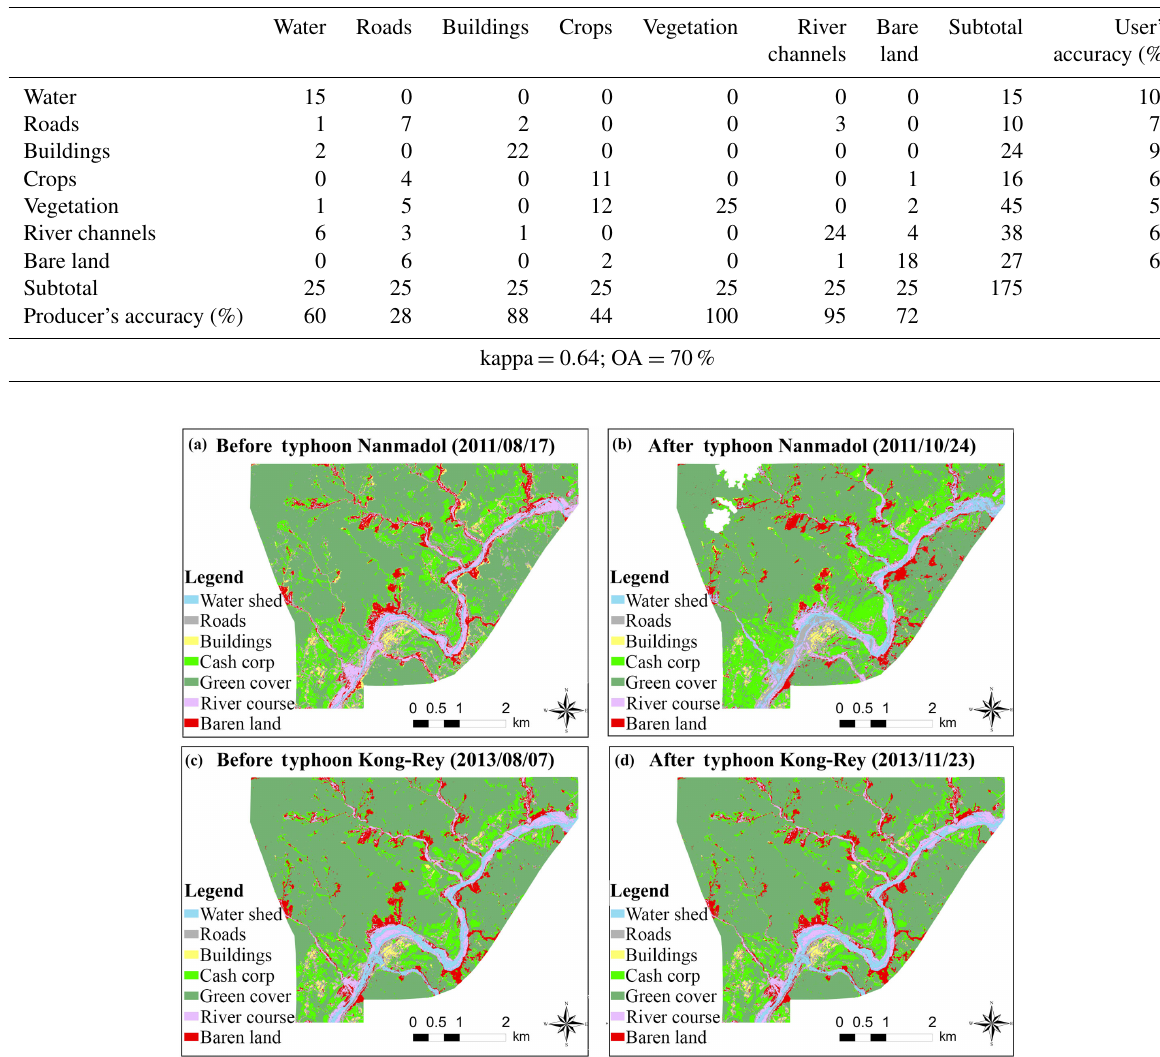
Table 2. Error matrix of interpretation results of satellite images after Typhoon Kong-rey in 2013.